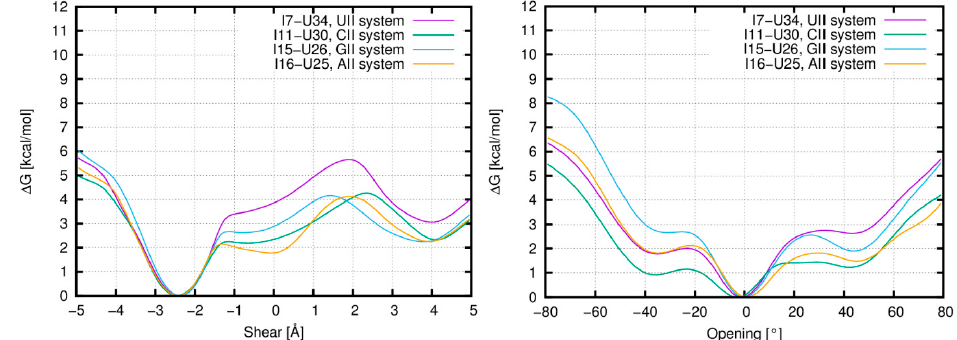
Figure 5. Free energy profiles of shear ( left ) and opening ( right ) for the first I–U base pair in the I–U/I–U tandem systems based on adaptive biasing method (ABF) simulations. ∆ G: Gibbs free energy